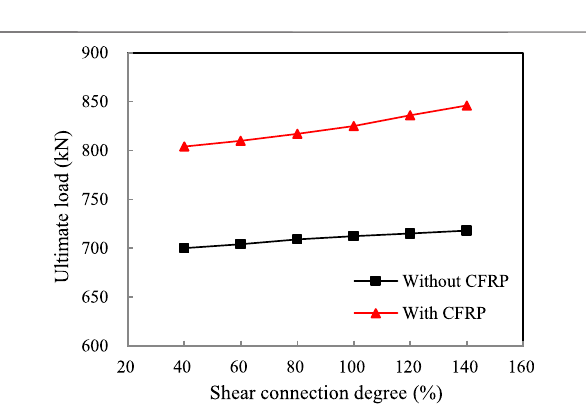
FIGURE 17 | Curve of the ultimate load varied with the degree of shear connection.